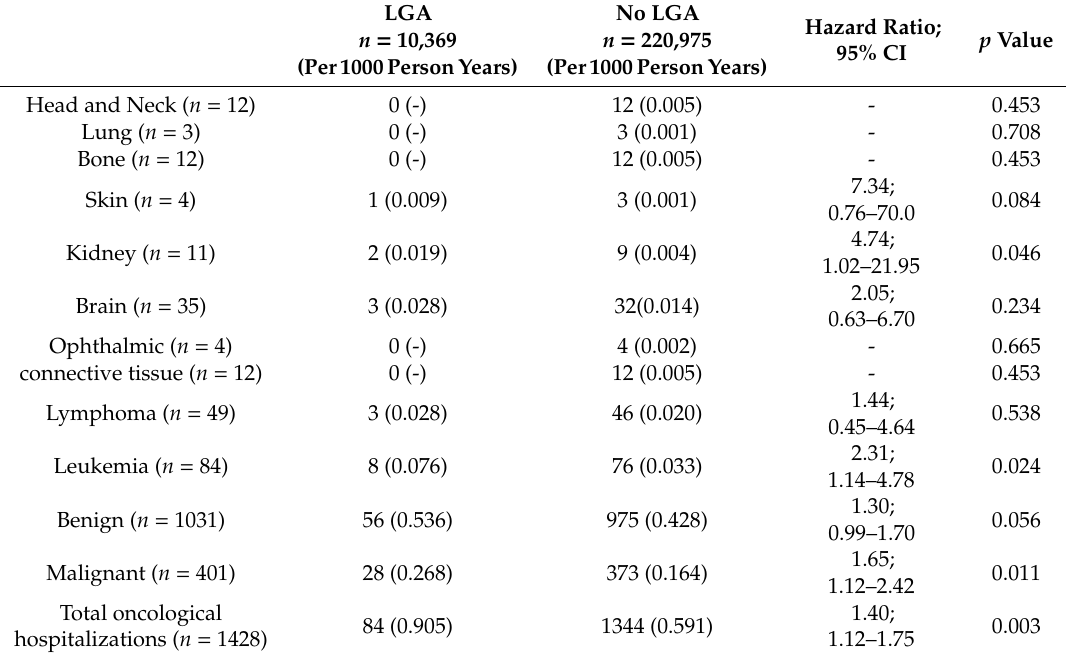
Table 2. The childhood malignancy rate (per 1000) following maternal history of LGA in index pregnancy vs. no